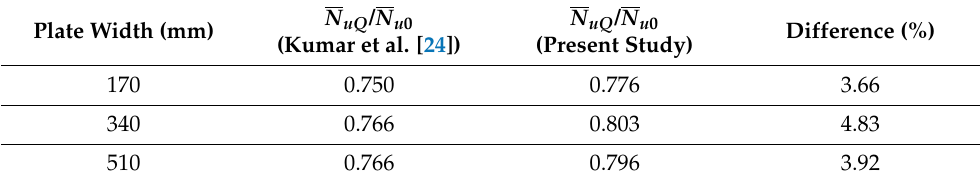
Table 6. Computational model verification by Kumar et al. [27].